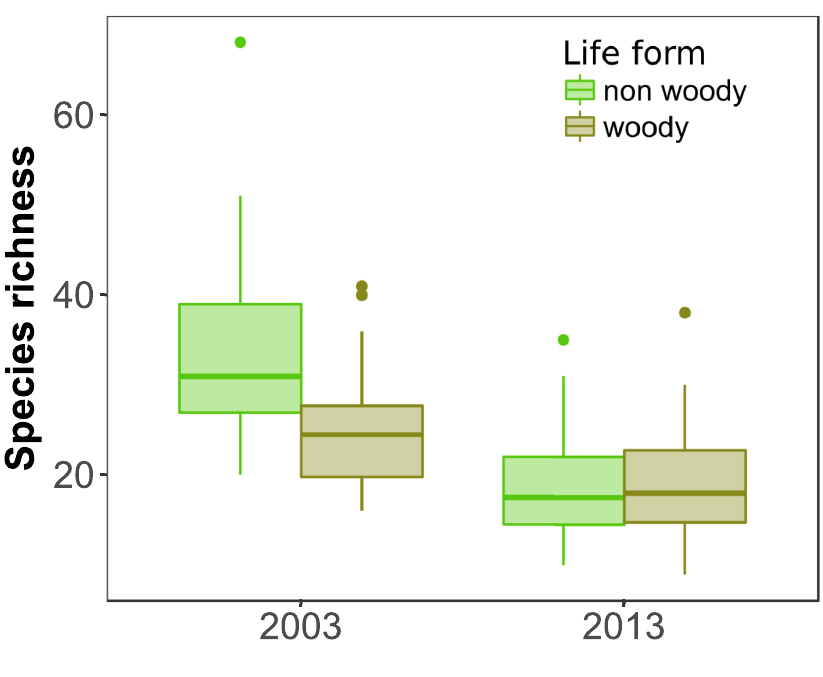
Fig 3. Richness of non-woody and woody plant species. Original surveys of plant species richness in 2003 and resurveys in 2013 for the same Chaco Serrano forest fragments. The bottom of each box is the 25th percentile and the top is the 75th percentile, horizontal lines correspond to the median, and whiskers indicate maximum observed values plus +1.5 interquartile range. Black dots are outliers.